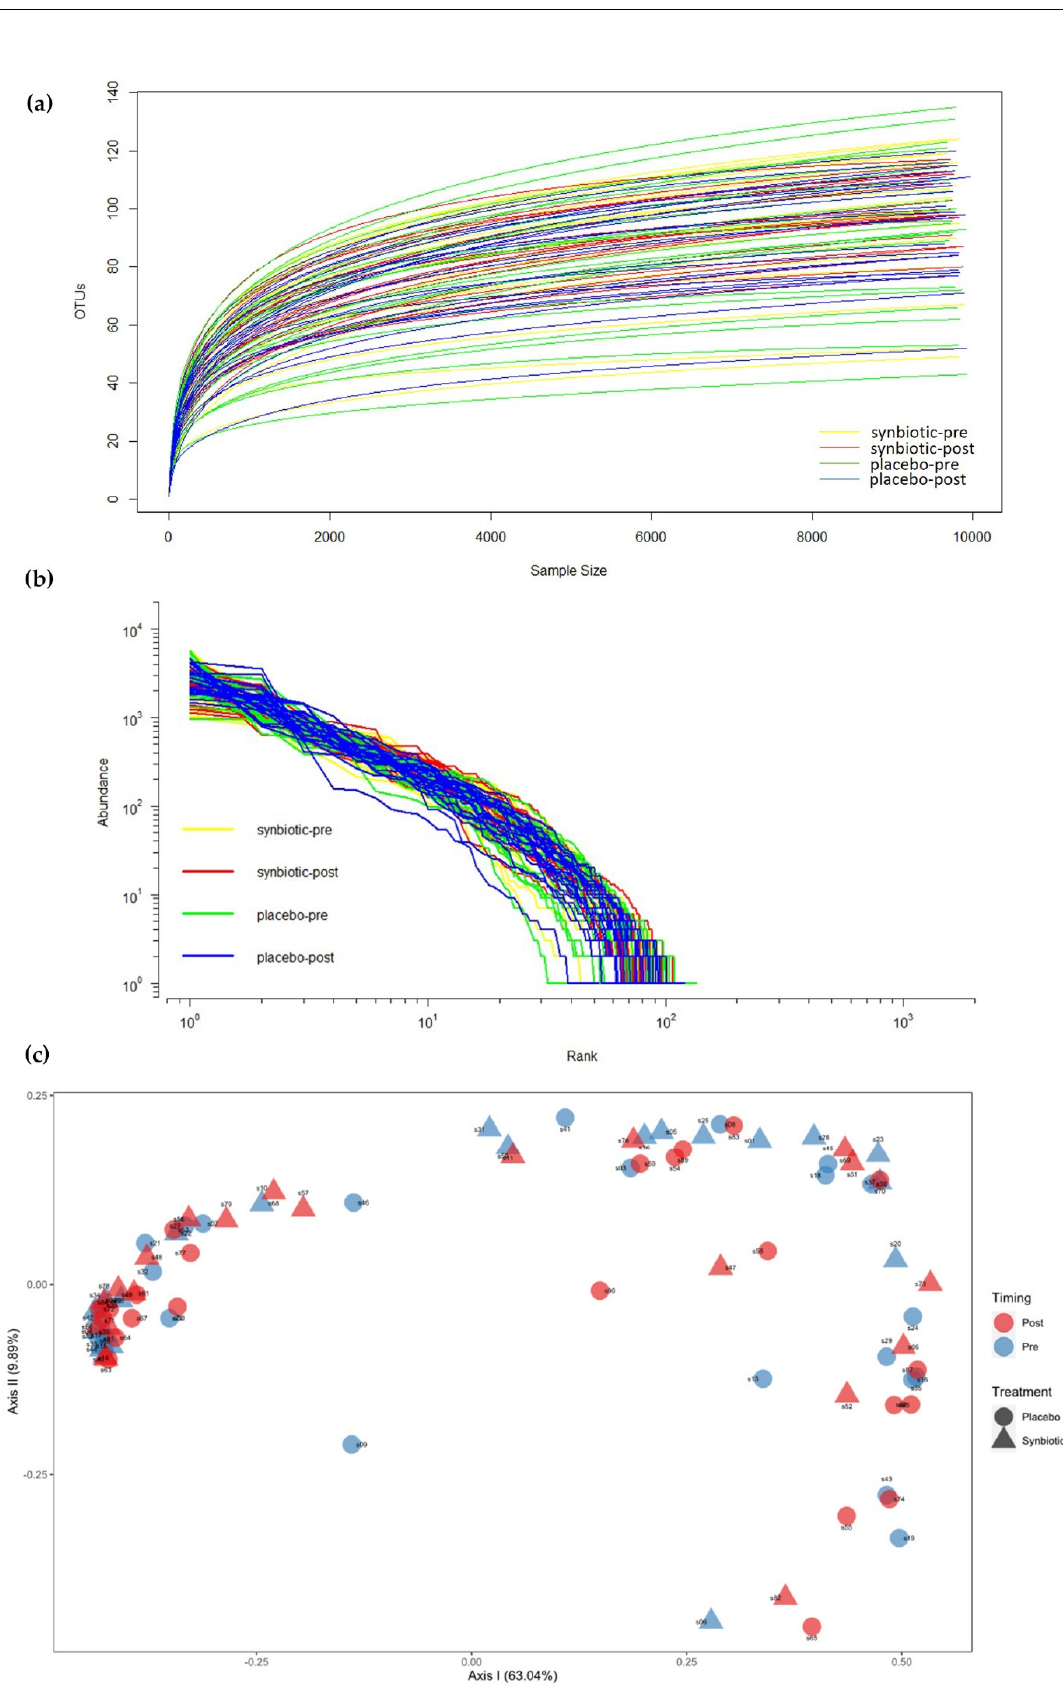
Figure 3. ( a ) Rarefaction curves from the synbiotic treatment group and the placebo group; ( b ) Rank abundance curve of the 16s rRNA gene; ( c ) Principal coordinate analysis (PCoA) comparing the four